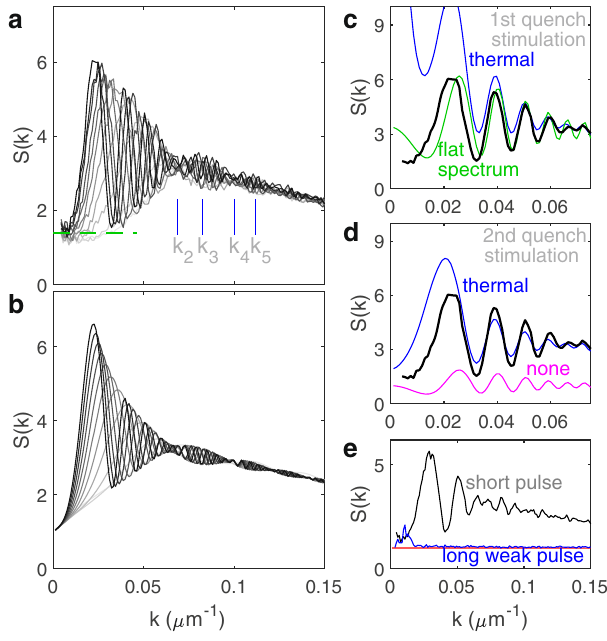
Fig. 3 Spontaneous and stimulated cosmological particle production. a The envelope of S ( k ). The black curves of Fig. 2b are among the curves shown. Darker gray indicates later time. The low- k limit is indicated by the green dashed line. The k p mark the nodes and antinodes. b The envelope of the theoretical curves. c The effect of stimulation in the fi rst quench, on S ( k ) after both quenches. The blue curve includes additional stimulation by a thermal distribution in the fi rst quench. The green curve includes stimulation by a fl at distribution in the fi rst quench rather than the second. τ = 153 ps is shown. d The effect of stimulation in the second quench. The blue curve includes additional stimulation by a thermal distribution in the second quench. The magenta curve includes no extra stimulation in either quench. τ = 153 ps is shown. e Effect of the interactions. The black curve is from Fig. 2b. The blue curve employs a pulse which is 500 times weaker and longer. The red curve is the theoretical prediction for the long, weak pulse. τ = 87 ps is